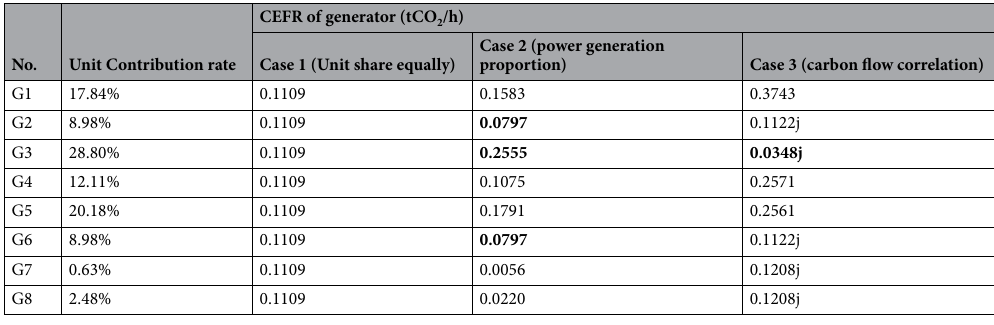
Table 9. Carbon emission shared by generators under three different allocation methods. Significance values are in bold.